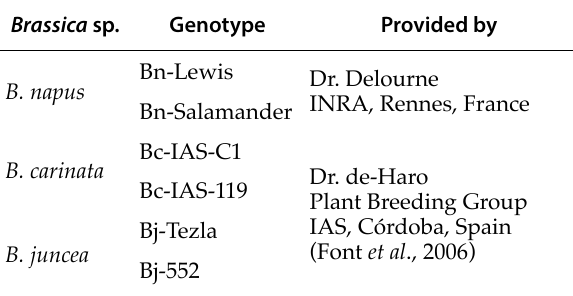
Table 1. Provenance of Brassica spp. and genotypes used in this